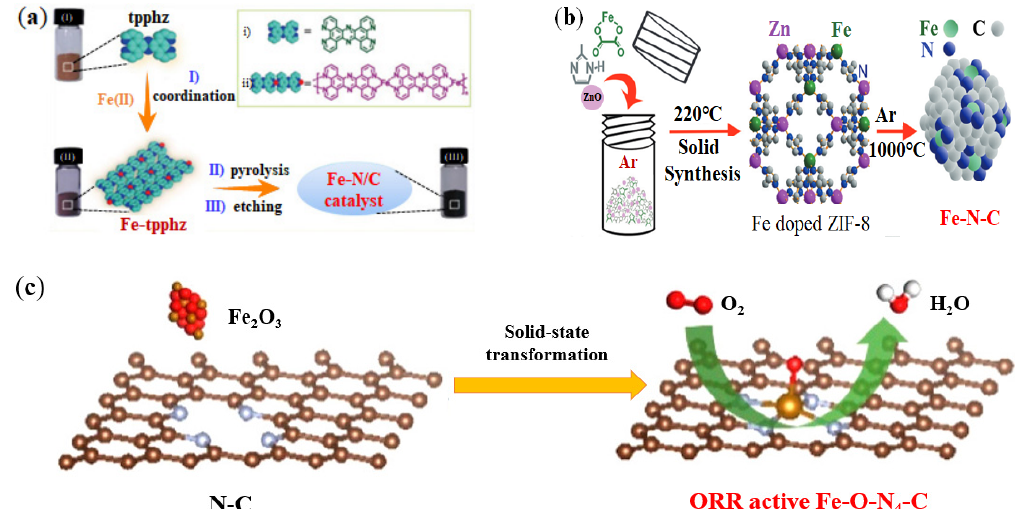
Figure 3. Synthesis methods of Fe-SACs: ( a ) Synthesis from Fe-tpphz complex. Adapted with per- mission from Ref. [66]. Copyright 2018 Royal Society of Chemistry. ( b ) Synthesis from Fe doped ZIF-8. Adapted with permission from Ref. [67]. Copyright 2018 John Wiley and Sons; ( c ) Synthesis from Fe 2 O 3 and ZIF-8. Adapted with permission from Ref. [72]. Copyright 2021 American Chemical Society.